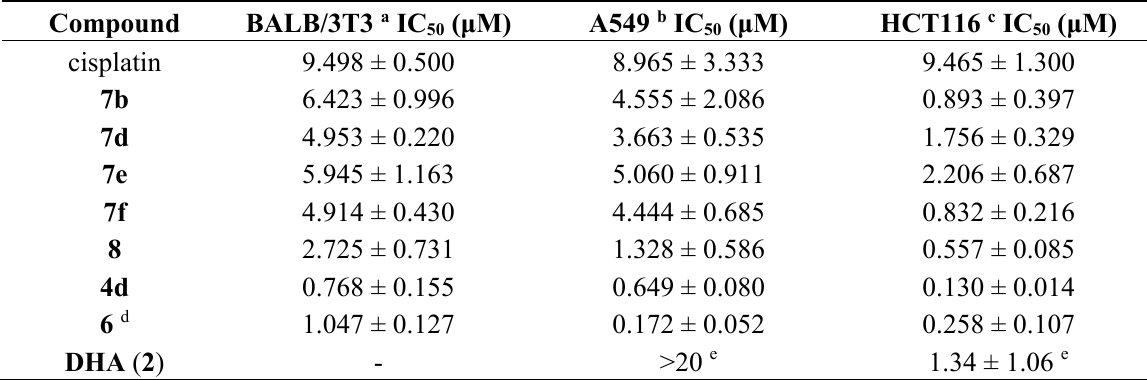
Table 2. Antiproliferative activity against cancer cell lines of A549 and HCT116, and cytotoxicity against normal mice fibroblast